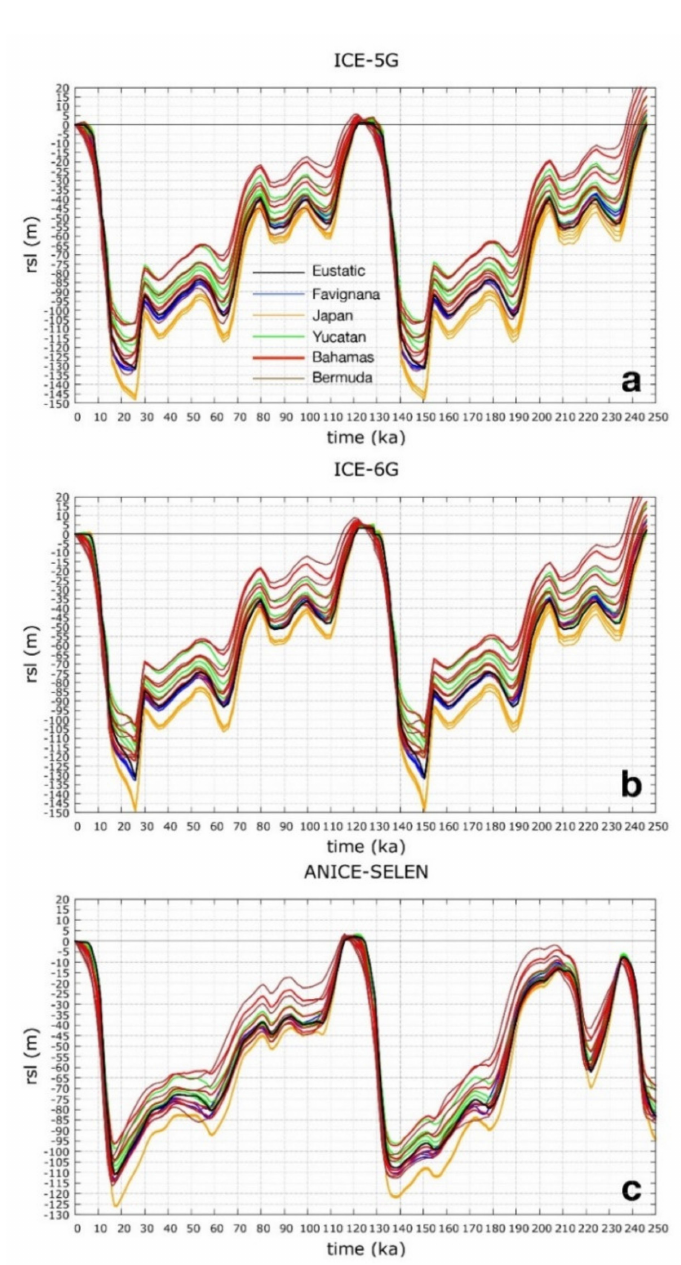
Figure 9. Cumulative predicted RSL curves for ICE-5G ( a ), ICE-6G ( b ), and ANICE-SELEN ( c ) ice- sheet models in combination with different mantle viscosity profiles (see legend and Tables 5 and 6 for details). The black curves represent the eustatic sea-level variation for each ice-sheet model. The colored curves represent the RSL change for each site under